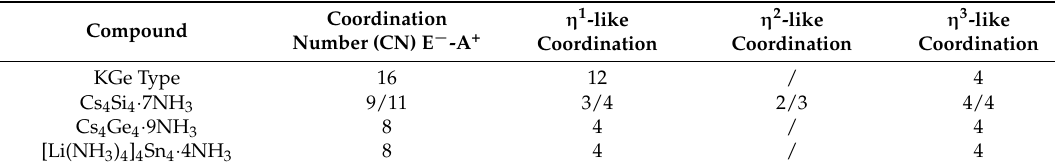
Table 6. Coordination number of the [E 4 ] 4 − cages in KGe and related ammoniates.